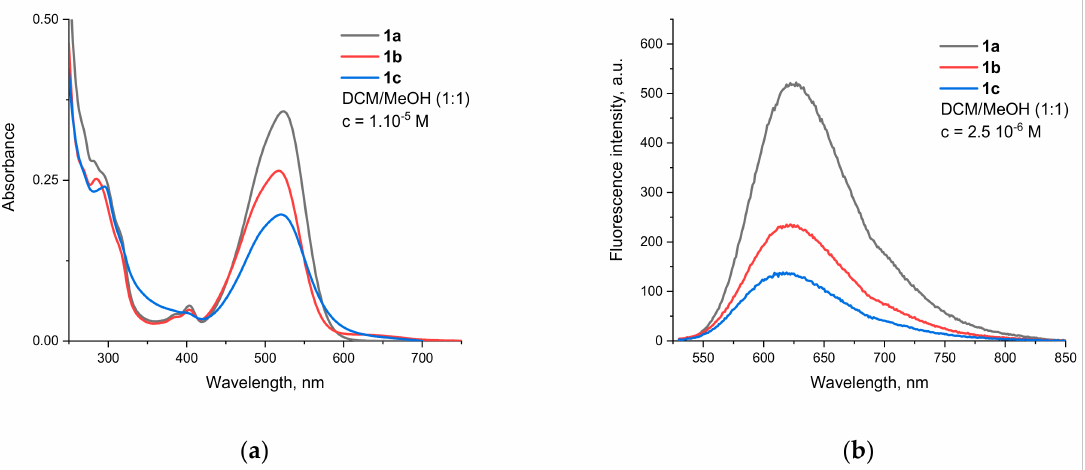
Figure 1. Spectra of compounds 1a–c in DCM/MeOH 1:1 (v/v). ( a ) Absorption. ( b ) Fluorescence (excitation wavelength 520